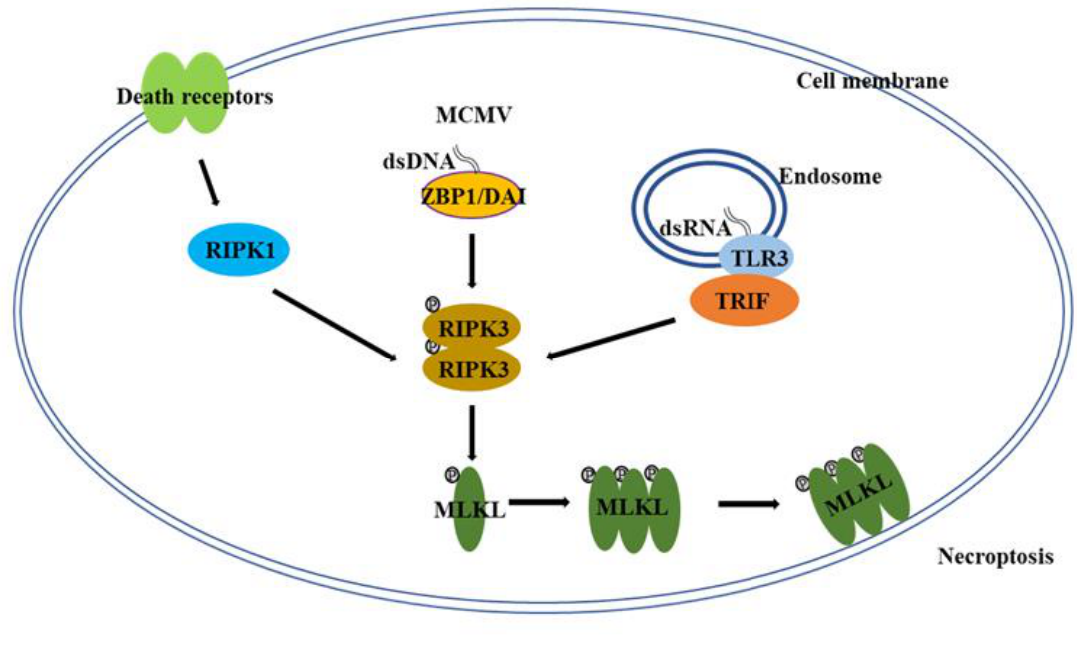
FIGURE 1: A simplified scheme of the molecular mechanism of necroptosis. In certain types of cells/tissues, necroptosis can be induced through different pathways under certain conditions including the engagement of death receptors and the infection of DNA or RNA viruses (MCMV: mouse cytomegalovirus). While RIPK3 and MLKL proteins are the core components of the necroptotic machinery, RIPK1, ZBP1/DAI, and TRIF are the key effectors that orchestrate the necroptotic process by recruiting RIPK3 in response to different stimuli. The aggregation of RIPK3 results in the autophosphorylation of the protein and the activated RIPK3 will phosphorylate MLKL and induce the oligomerization of MLKL, which then initiates the execution of necroptosis. DAI: DNA-dependent activator of interferon; MLKL: mixed lineage kinase do- main-like; RIPK: receptor interacting protein kinase; TRIF: Toll-interleukin receptor-domain-containing adapter-inducing interferon- β; ZBP: Z - DNA-binding